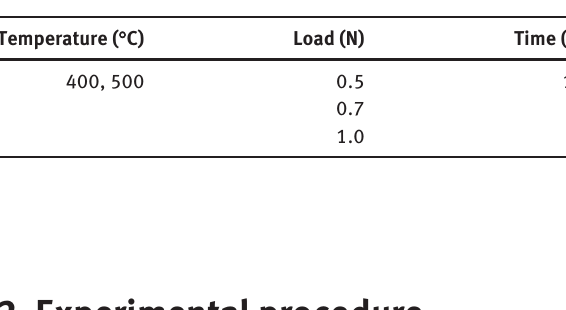
Figure 2 Overall aspect of the matrix and presence of the θ or Al phase formed in the matrix grain boundaries, as revealed by slight etching.